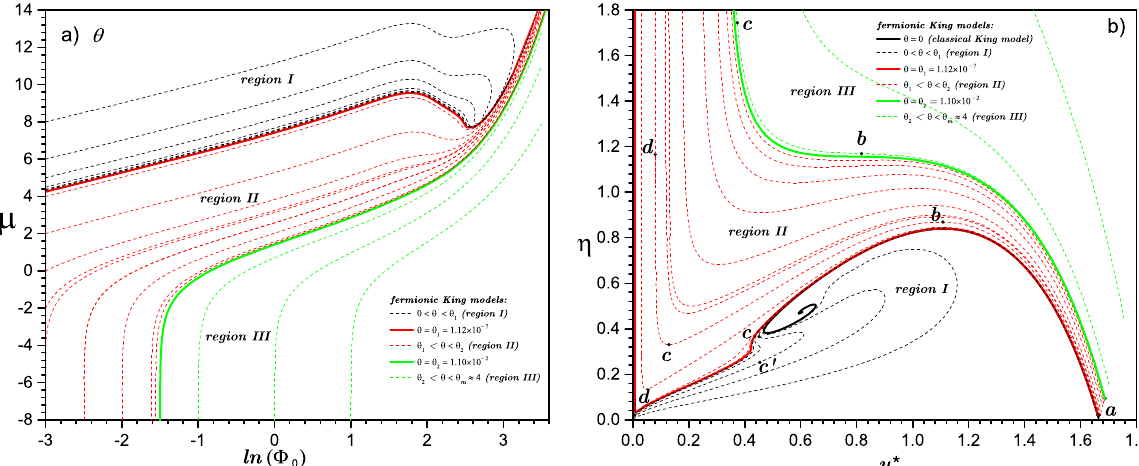
Figure 2. ( a ): Contour maps of the mass ratio parameter θ = M F / M [see in Equation (25)] in the plane of integration parameters [ Φ 0 , µ ] of the Poisson problem (27), which were obtained from numerical procedures designed to fulfil this purpose. Here, µ = ln α is the degeneration parameter defined from the normalization constant α in Equation (42); Φ 0 is the central value of the dimensionless potential (26). Notice that for each value of the degeneration parameter µ there exist infinite values for the mass ratio parameter θ since this quantity also depends on the dimensionless potential Φ 0 , θ = θ ( Φ 0 , µ ) . This very fact implies that thermodynamics of fermionic King model at constant degeneration parameter µ differs from its thermodynamics at constant mass ratio θ (or constant total mass M ). ( b ): Corresponding caloric curves at constant mass ratio parameter θ in terms of the dimensionless inverse temperature η = β GMm / R and the auxiliary variable u ∗ = − GM 2 / RU defined from the total energy U . One can observed the existence of three regions with different thermodynamic behavior. The points ( a , b , c , c (cid:48) , d ) are some notable configurations. Among them, it is remarkable the case of configurations ( c , c (cid:48) ) over the curve with θ = 2.84 × 10 − 8 (region I), which exhibit the same energy but different temperatures . The during discontinuous jump from the profile c towards the profile c (cid:48) , the system temperature grows and there exist a redistribution of the mass that leads to the formation of a dense degenerate core. After